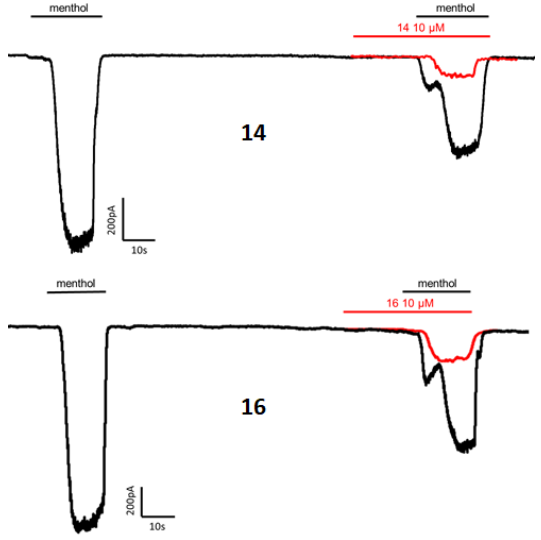
Figure A2. Compounds 14 and 16 inhibited TRPM8-mediated currents studied by whole cell Patch clamp. Representative menthol-evoked rTRPM8 current registered at a holding potential of -60 mV for control condition with two pulses of 100 μM menthol (black traces) and test condition with 30s perfusion of 10 μ M 14 and 16 (red traces) before the second menthol pulse.